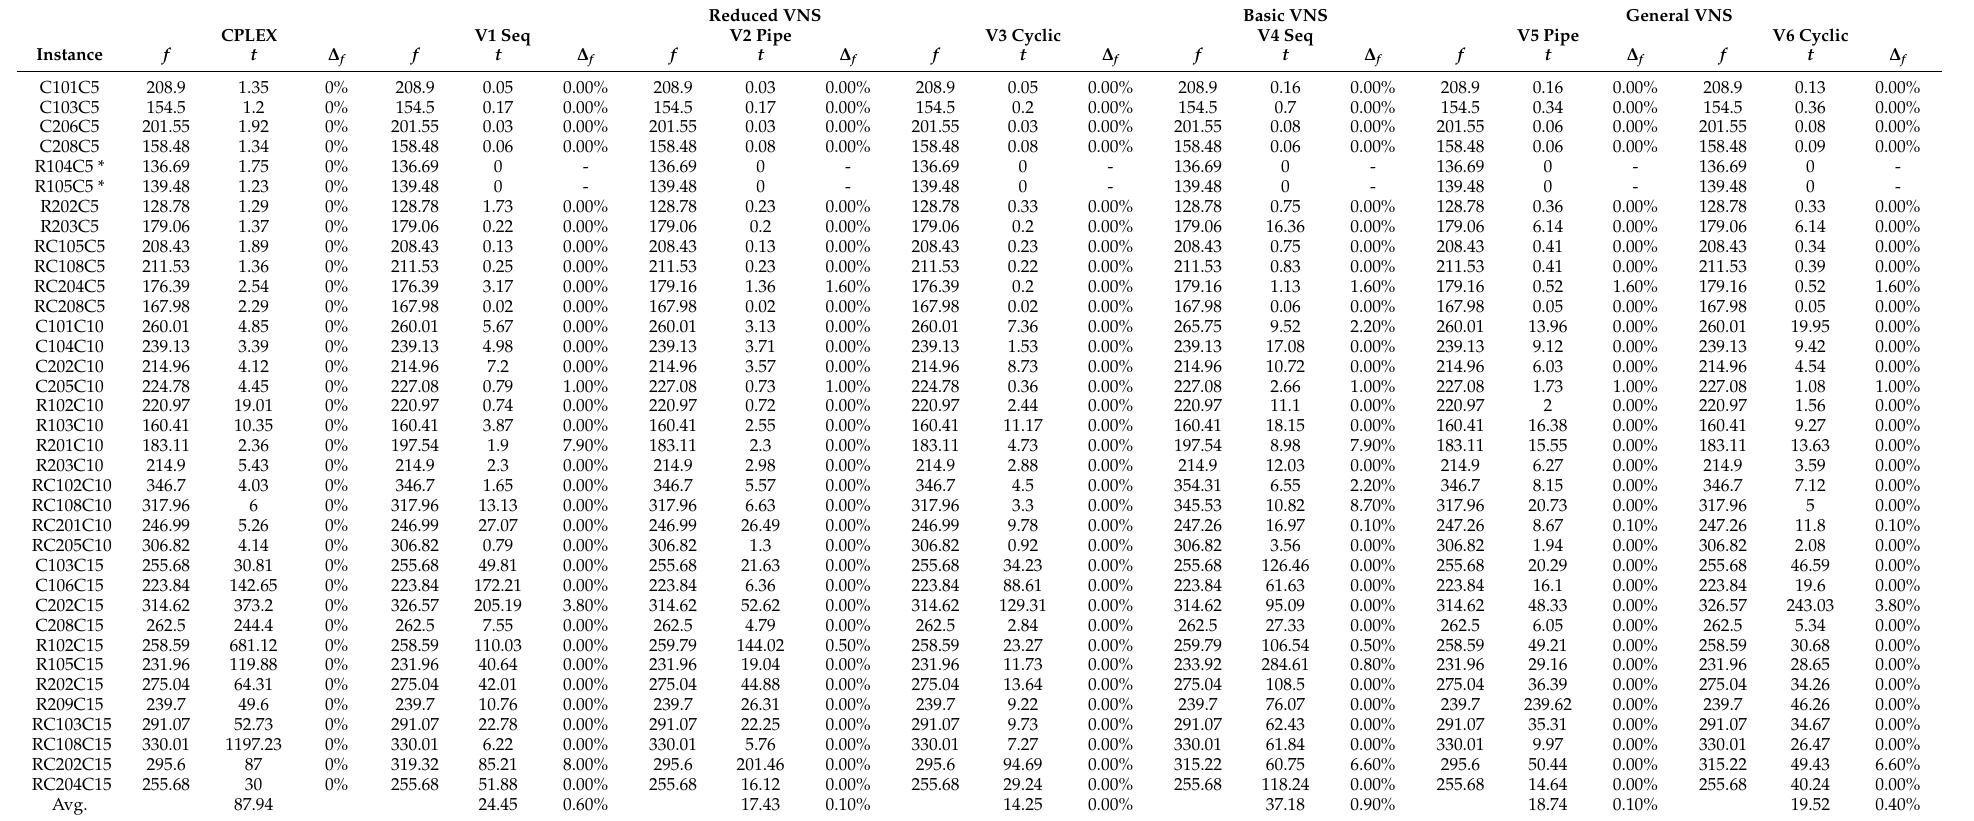
Table 5. Comparison of CPLEX vs. VNS variant results on small-sized